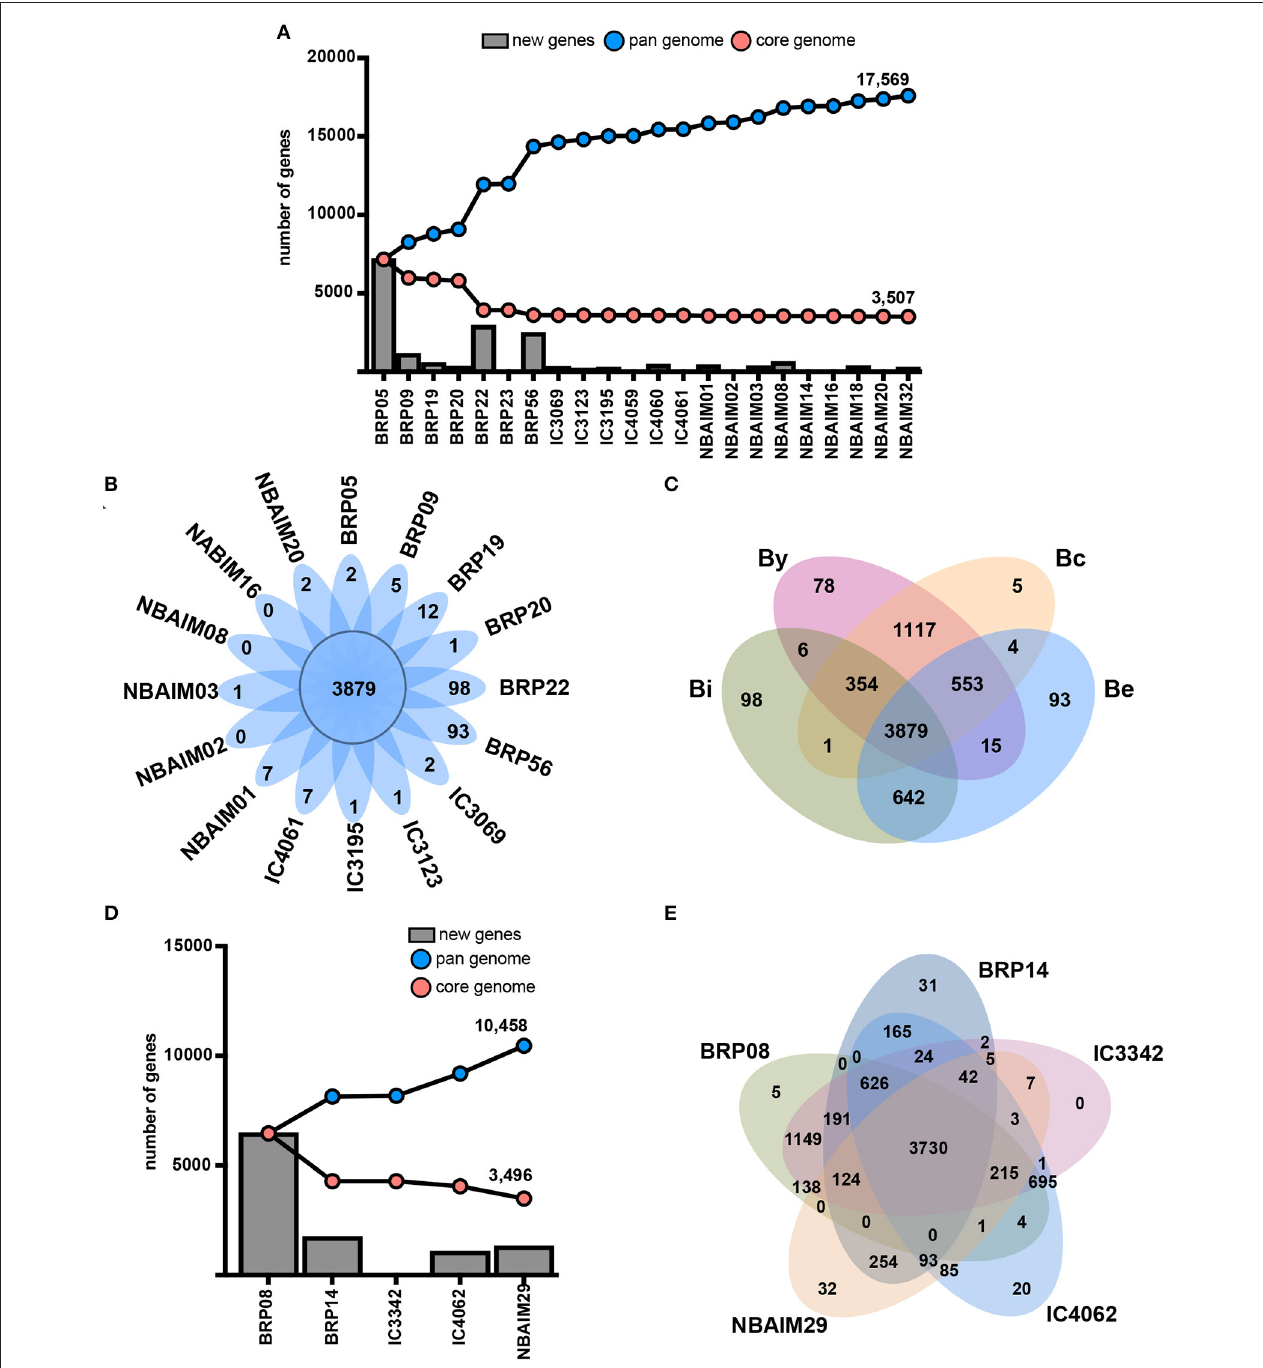
FIGURE 8 | Genetic features. (A) Core genome and pangenome of Bradyrhizobium where X-axis shows strains and the Y-axis, the number of genes. Blue line: pangenome. Red line: core genome. New genes: bars. (B) Core and exclusive orthologue clusters for each Bradyrhizobium strain. (C) Venn diagram showing shared and exclusive orthologue families among nodulation-type groups. By: the B. yuanmingensenod -type group. Bc: the B. cajaninod -type group. Be: the B. elkaniinod -type group. Bi: the B. icensenod -type group. (D) Coregenome and pangenome of Ensifer where X-axis shows strains and the Y-axis, the number of genes. Blue line: pangenome. Red line: core genome. New genes: bars. (E) Core and exclusive orthologue clusters for each Ensifer strain. related to NF modifications, nolY , nodK , nodY , nolO , nolN , Bc, Be, and Bi ( Figures 4 , 5 ). The IU and IC Bradyrhizobium nolL , or noeE for each Bradyrhizobium nodC type group, By, strains either have nodY or nodK between nodD1 and